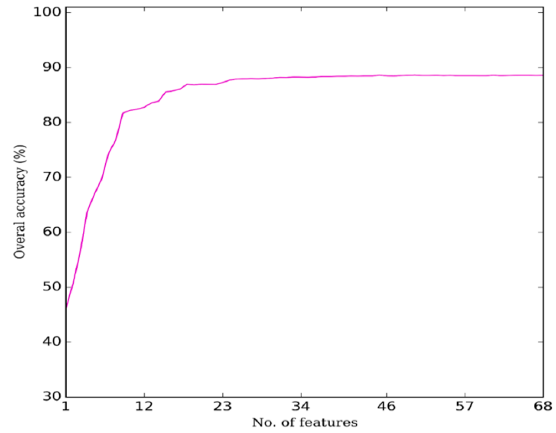
Figure 3. Variation of the confusion matrix-based overall accuracy (%) with respect to the number of features used.